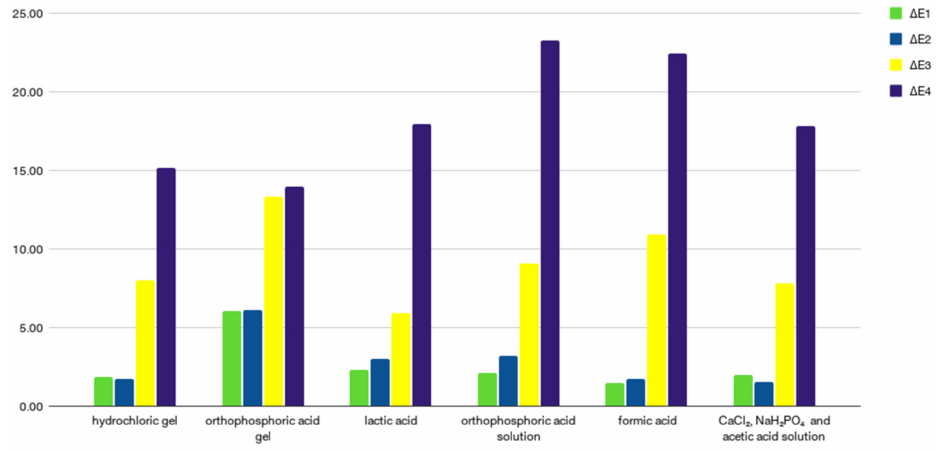
Figure 8. The changes in time for each acidic